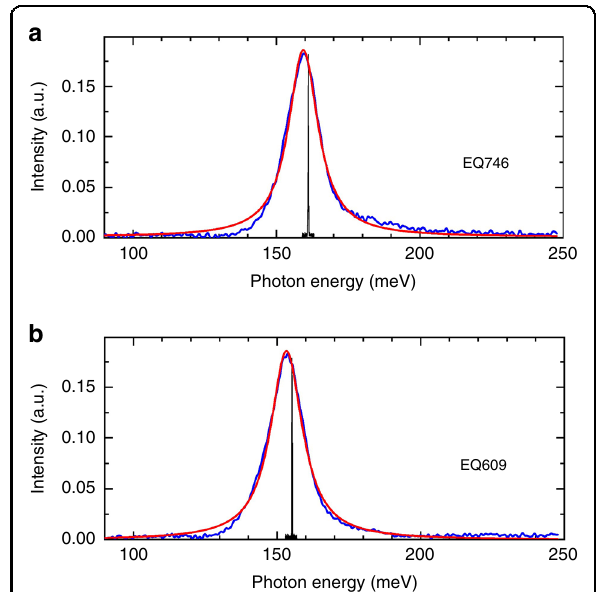
Fig. 16 Emission spectra of the lasers measured at 300 K at a current density of 400 A cm − 2 ( ∼ 0.5 J th ) and above the threshold (black lines). a QCL grown on a native InAs substrate, b QCL grown on a Si substrate. Red curves show Lorentzian fi ts of the spectra. Reprinted from ref. 34 , used in accordance with the Creative